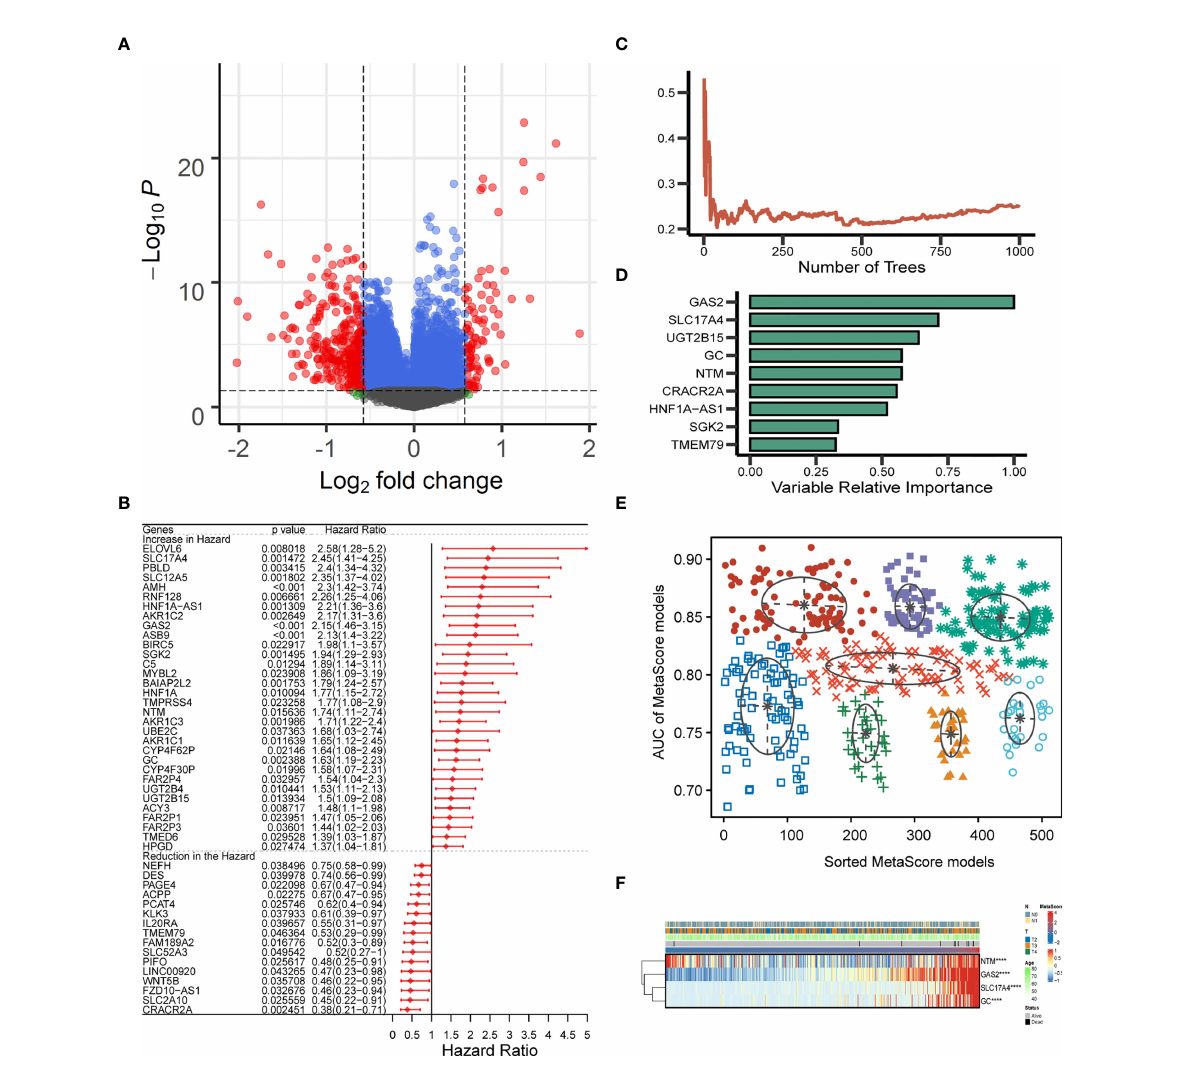
FIGURE 2 Establishment and veri fi cation of MetaScore signature. (A) The volcano plot of mRNA levels expression of metabolism genes. The abscissa is the log2 value of the screening condition, the ordinate is the log10 transformed p-value. The red-colored dots represent the DEGs (|logFC|> log2 (1.5) and P< 0.05). (B) Univariate Cox analysis of 48 selected genes. (C, D) The error rate of the random trees and variable relative importance for the 9 metabolism-related genes. (E) The pattern of the logistic regression model is related to the AUC scores and is veri fi ed by a Gaussian mixture, including 8 clusters of 511 combinations. (F) The heat map revealed the relationship between the four-gene signature and distribution of MetaScore ****P <